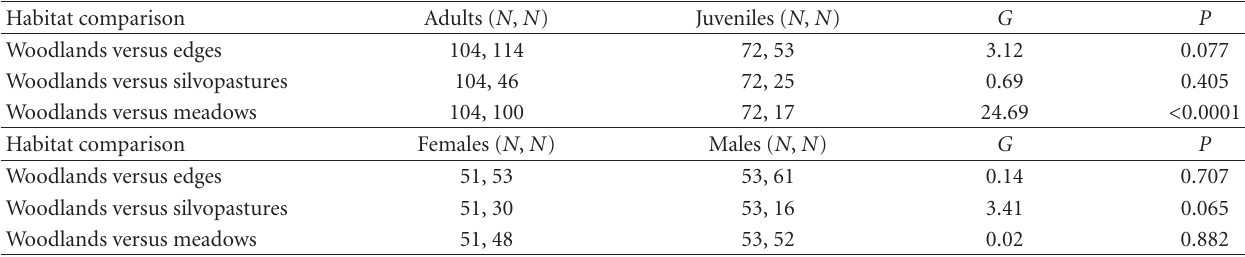
Table 3: Results of G -tests of independence comparing age-class and sex ratios of Plethodon cinereus between reference woodlands and three agriculturally disturbed habitats in southern West Virginia, 2004-2005. Numbers of captures within each habitat type are separated by commas. Significance was set at P ≤ 0 . 0167 and df = 1 for all